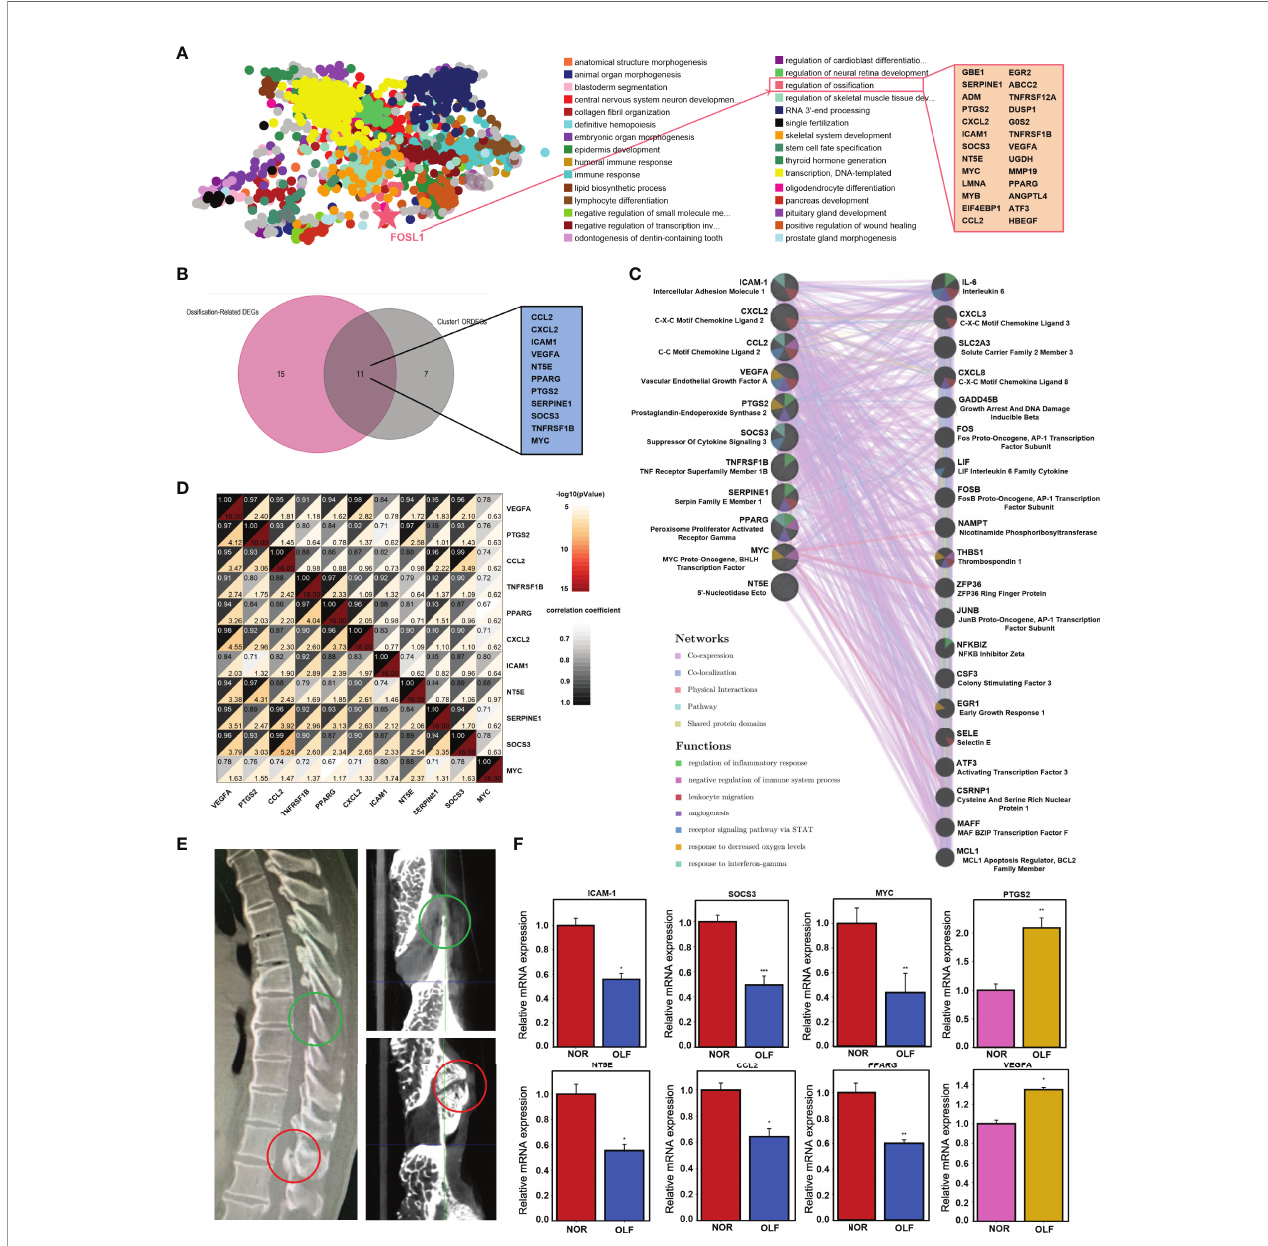
FIGURE 6 | TF enrichment analysis and qRT-PCR validation of hub ORDEGs. (A) TF enrichment analysis by ChEA3 identi fi ed 28 genes with function of regulating ossi fi cation. (B) Venn diagram showed the intersection between 28 genes and the leading cluster genes to obtain the 11 candidate ORDEGs. (C) Candidate ORDEGs and their co-expression genes were analyzed using GeneMANIA. (D) Correlation analysis of 11 candidate ORDEGs. (E) Sagittal CT imaging of one TOLF patient and micro-CT views of its clinical specimen. (F) Validation of the expression of these genes by qRT-PCR. The expression levels of CCL2, ICAM-1, MYC, NT5E, PPARG, PTGS2, and SOCS3 were down-regulated, which were paralleled with microarray results, but PTGS2 and VEGFA were up-regulated. *p < 0.05, **p < 0.01, ***p <